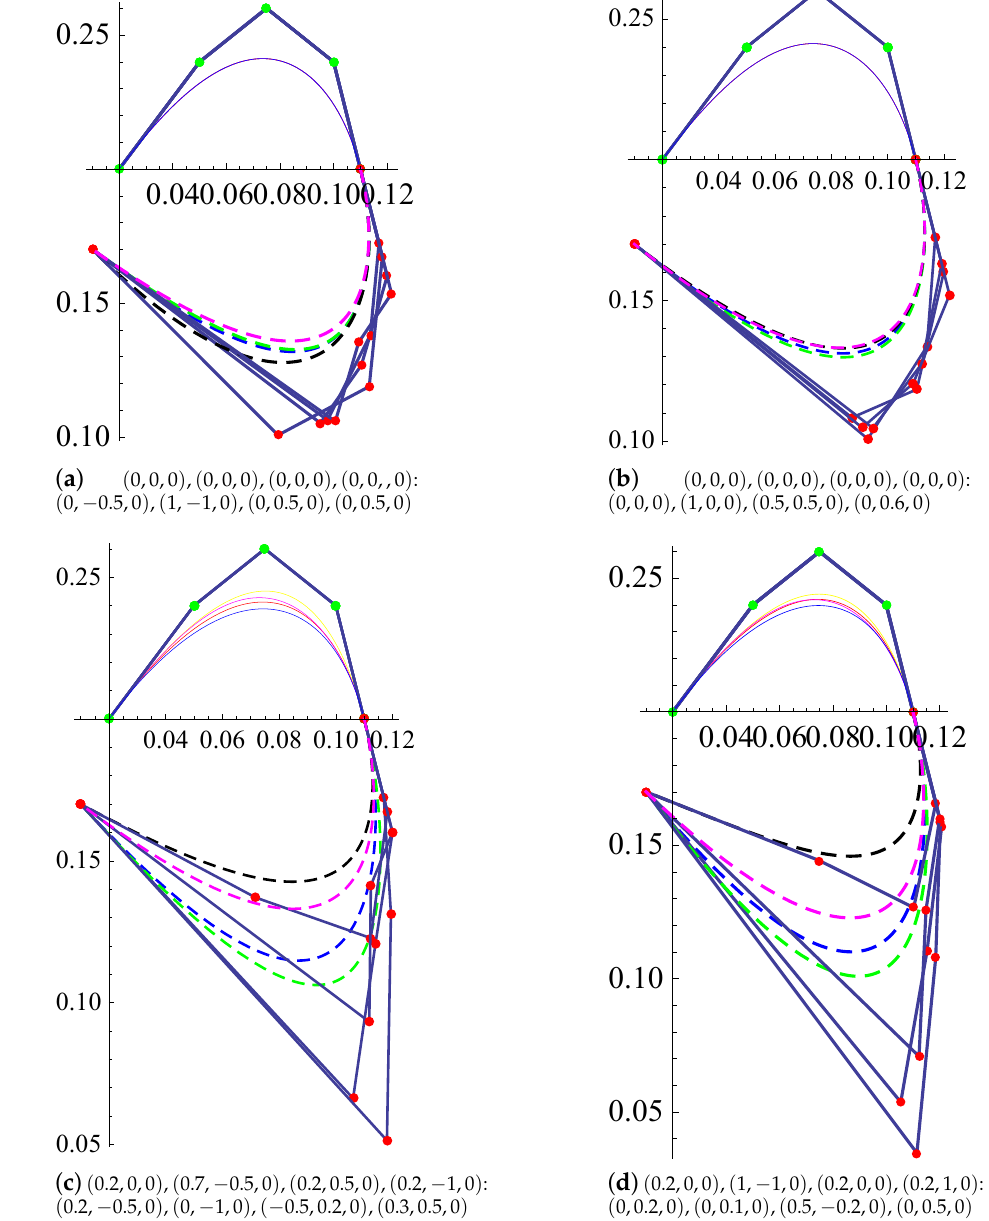
Figure 6. Graphical representation ofthe C 3 continuity ofthe GHT-Béziercurve by variousshape parameters. ( a ) ( 0,0,0 ) , ( 0,0,0 ) , ( 0,0,0 ) , ( 0,0,,0 ) : ( 0, 0.5,0 ) , ( 1, 1,0 ) , ( 0,0.5,0 ) , ( 0,0.5,0 ) ; ( b ) ( 0,0,0 ) , ( 0,0,0 ) , − − ( 0,0,0 ) , ( 0,0,0 ) : ( 0,0,0 ) , ( 1,0,0 ) , ( 0.5,0.5,0 ) , ( 0,0.6,0 ) ; ( c ) ( 0.2,0,0 ) , ( 0.7, 0.5,0 ) , ( 0.2,0.5,0 ) , ( 0.2, − ( 0.2, 0.5,0 ) , ( 0, 1,0 ) , ( 0.5,0.2,0 ) , ( 0.3,0.5,0 ) ; ( d ) ( 0.2,0,0 ) , ( 1, 1,0 ) , ( 0.2,0,0 ) , ( 0.2,1,0 ) : ( 0,0.2,0 ) , − − − − ( 0,0.1,0 ) , ( 0.5, 0.2,0 ) , ( 0,0.5,0 ) −